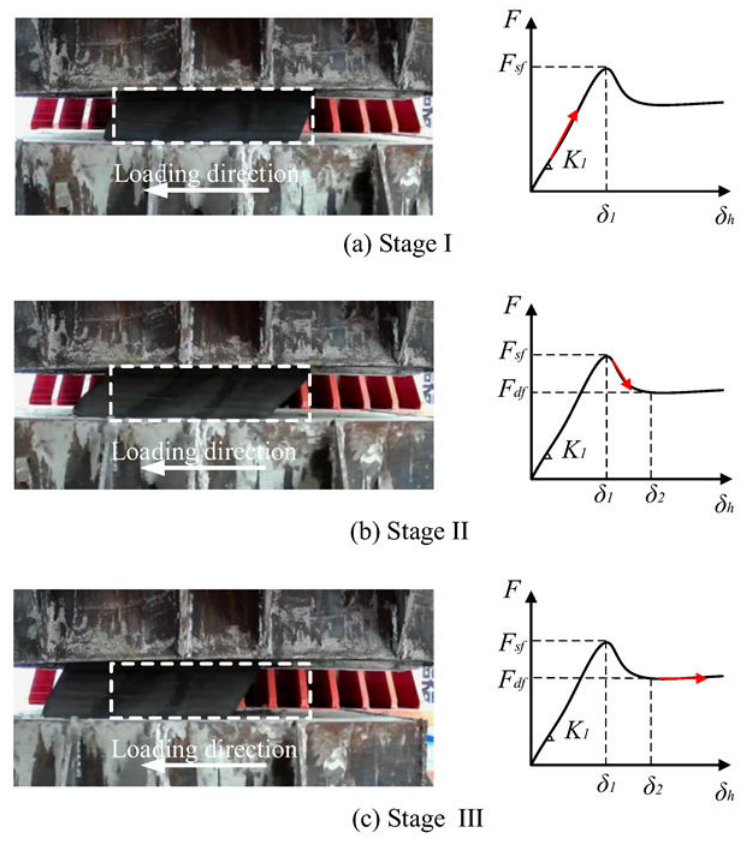
Figure 5. Hysteretic behavior of LRBs under displacement loading.